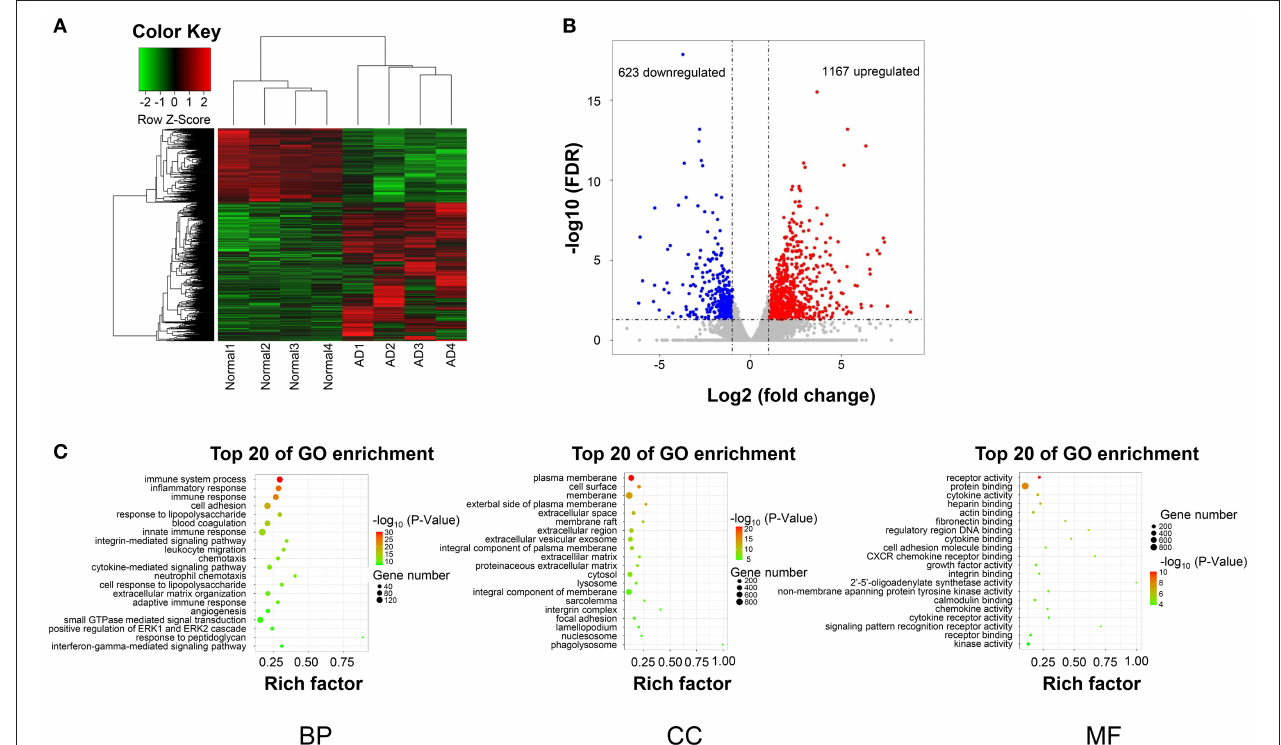
FIGURE 2 | DEGs hierarchical clustering analysis and functional annotation. (A) Heatmap of DEGs. The vertical axis represents DEGs. The horizontal axis represents the sample. DEGs are effectively divided into AD and normal groups. Red indicates upregulated genes and green represents downregulated genes. (B) The volcano plot of DEGs. The vertical axis represents -log 10 False Discovery Rate (FDR) and the horizontal axis represents log 2 fold change (log2FC). The DEGs were selected according to FDR < 0.05 and |log2FC| > 1, and the number of upregulated genes is 1167 and the number of down genes is 623. The blue and red dots represent DEGs and black dots represent nondifferential expressed genes. (C) The top 15 enriched GO terms (biological process, cellular component, and molecular function) of the DEGs,